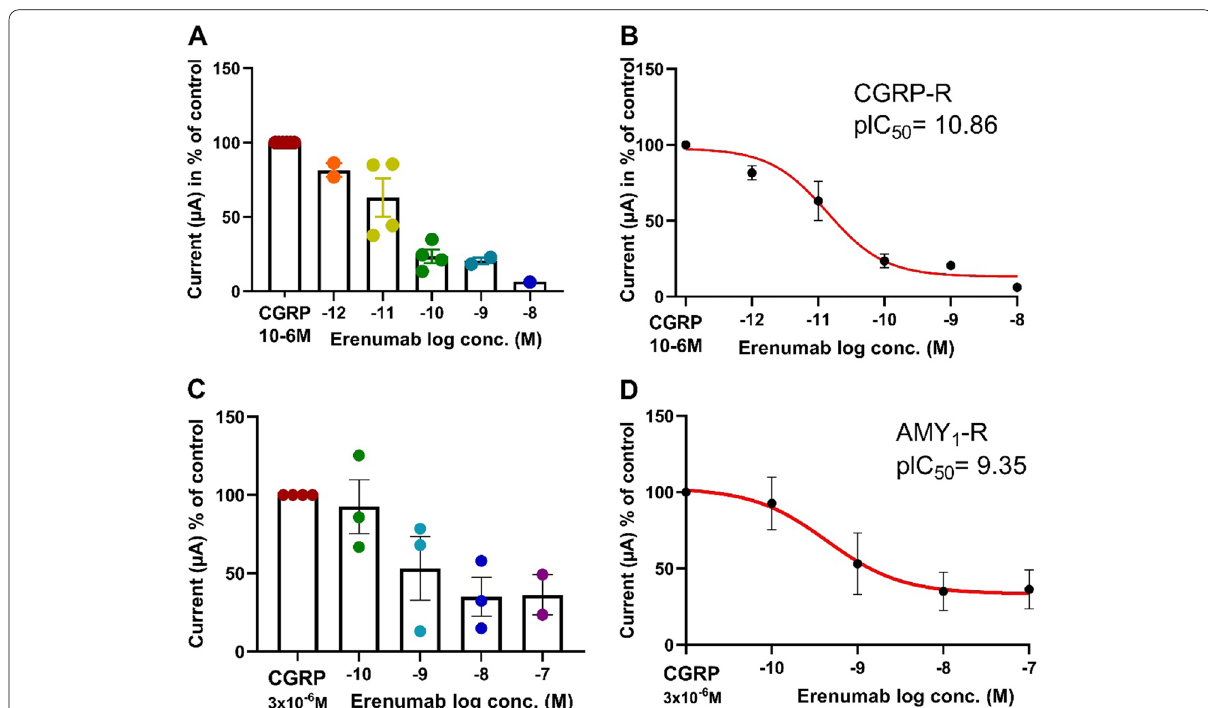
Fig. 5 The experiments show the erenumab inhibition of CGRP induced currents in Xenopus Laevis oocytes expressing CGRP‑R ( A & B ) and AMY 1 ‑R ( C & D ). In A‑D , the currents induced by CGRP at each concentration of erenumab is given in % of the current obtained for CGRP without antagonist in 4‑6 batches of oocytes. At a given concentration of erenumab in A & C each point represents the mean of 2‑4 identical experiments in one batch of oocytes. In B & D the least square non‑lin fit of the c‑r relationship of log[erenumab] vs. response (three parameters) is shown for responses performed on CGRP‑R ( A ) and AMY 1 ‑R ( C ). The 23 data points shown in Fig. A are obtained from experiments performed on 48 oocytes from six different batches. The same 23 data points are used for the curve fitting in B . The 15 data points shown in C are obtained from experiments performed on 37 oocytes from 4 different batches. The same 15 data points are used for the curve fitting in